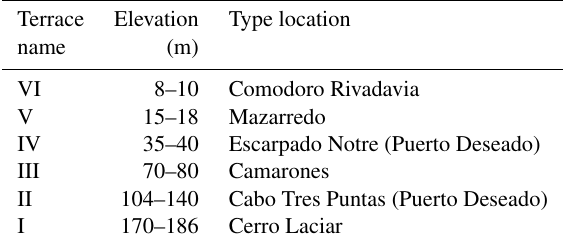
Table 1. Terrace levels identified by Feruglio